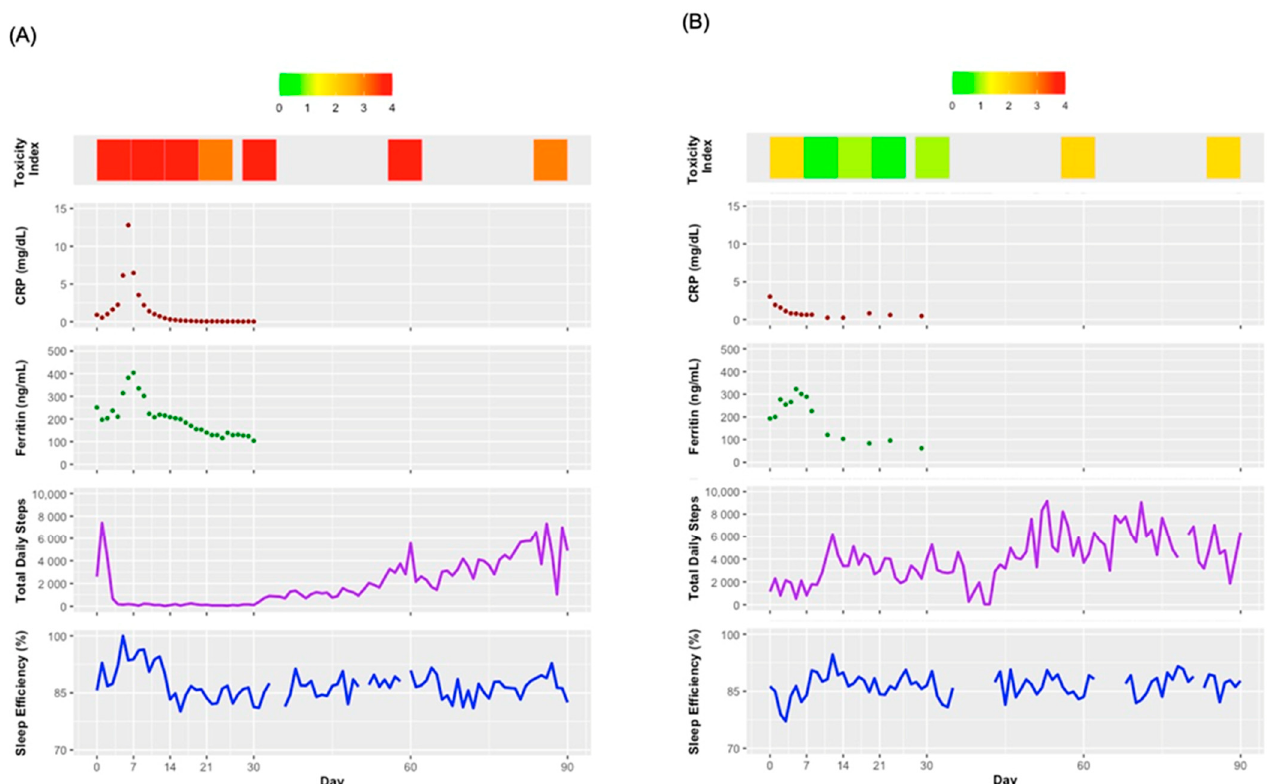
Figure 3. ( A ) Toxicity index scores, CRP, ferritin, total daily steps, and sleep efficiency over time for an example participant who had a partial response or better at day 90 but had a prolonged hospitalization post-CAR-T infusion. ( B ) Toxicity Index scores, CRP, ferritin, total daily steps, and sleep efficiency over time for an example participant who had progressive disease at day 90. Abbreviations: CRP, C-reactive protein; mg/dL, milligrams per deciliter; ng/mL, nanograms per milliliter.